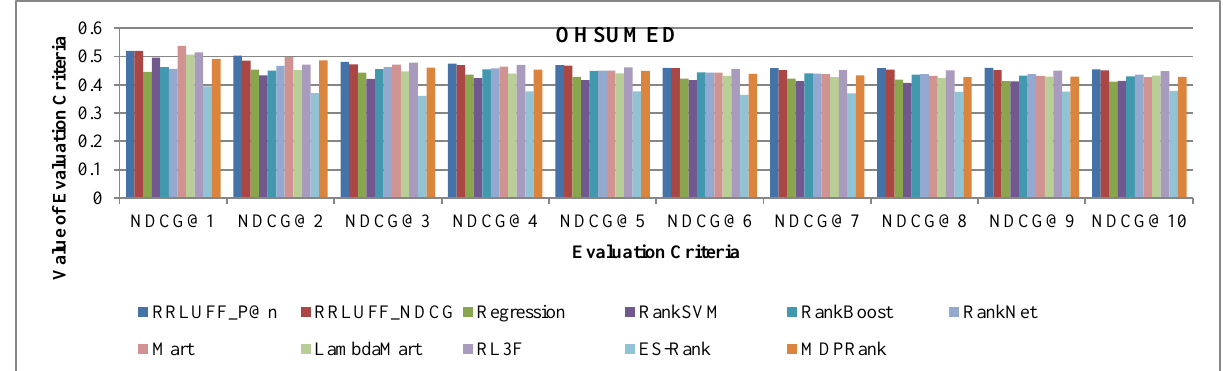
Figure 4. Comparison between the proposed algorithm and algorithms expressed regarding the evaluation criterion NDCG@n on OHSUMED